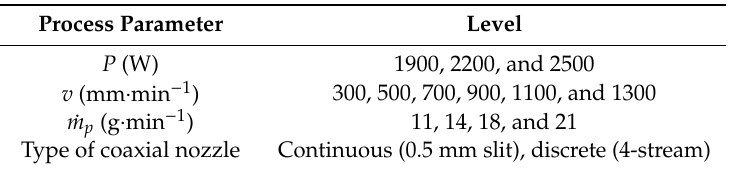
Table 2. Process parameter